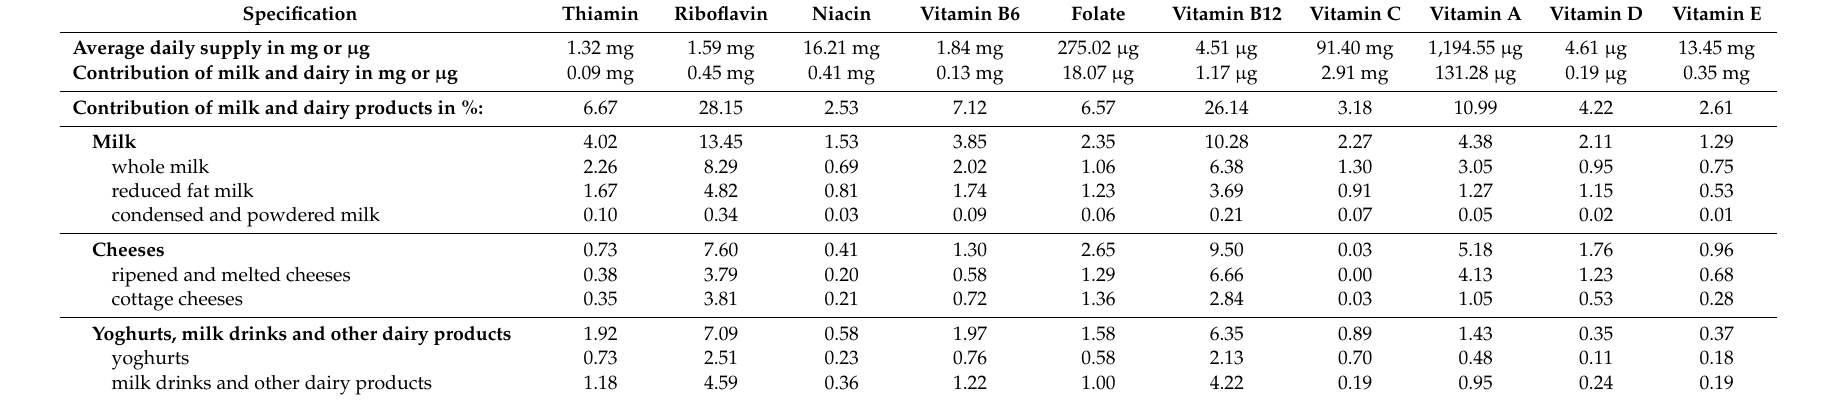
Table 7. Dairy sources of vitamin contribution to the average Polish diet (in mg or µ g and